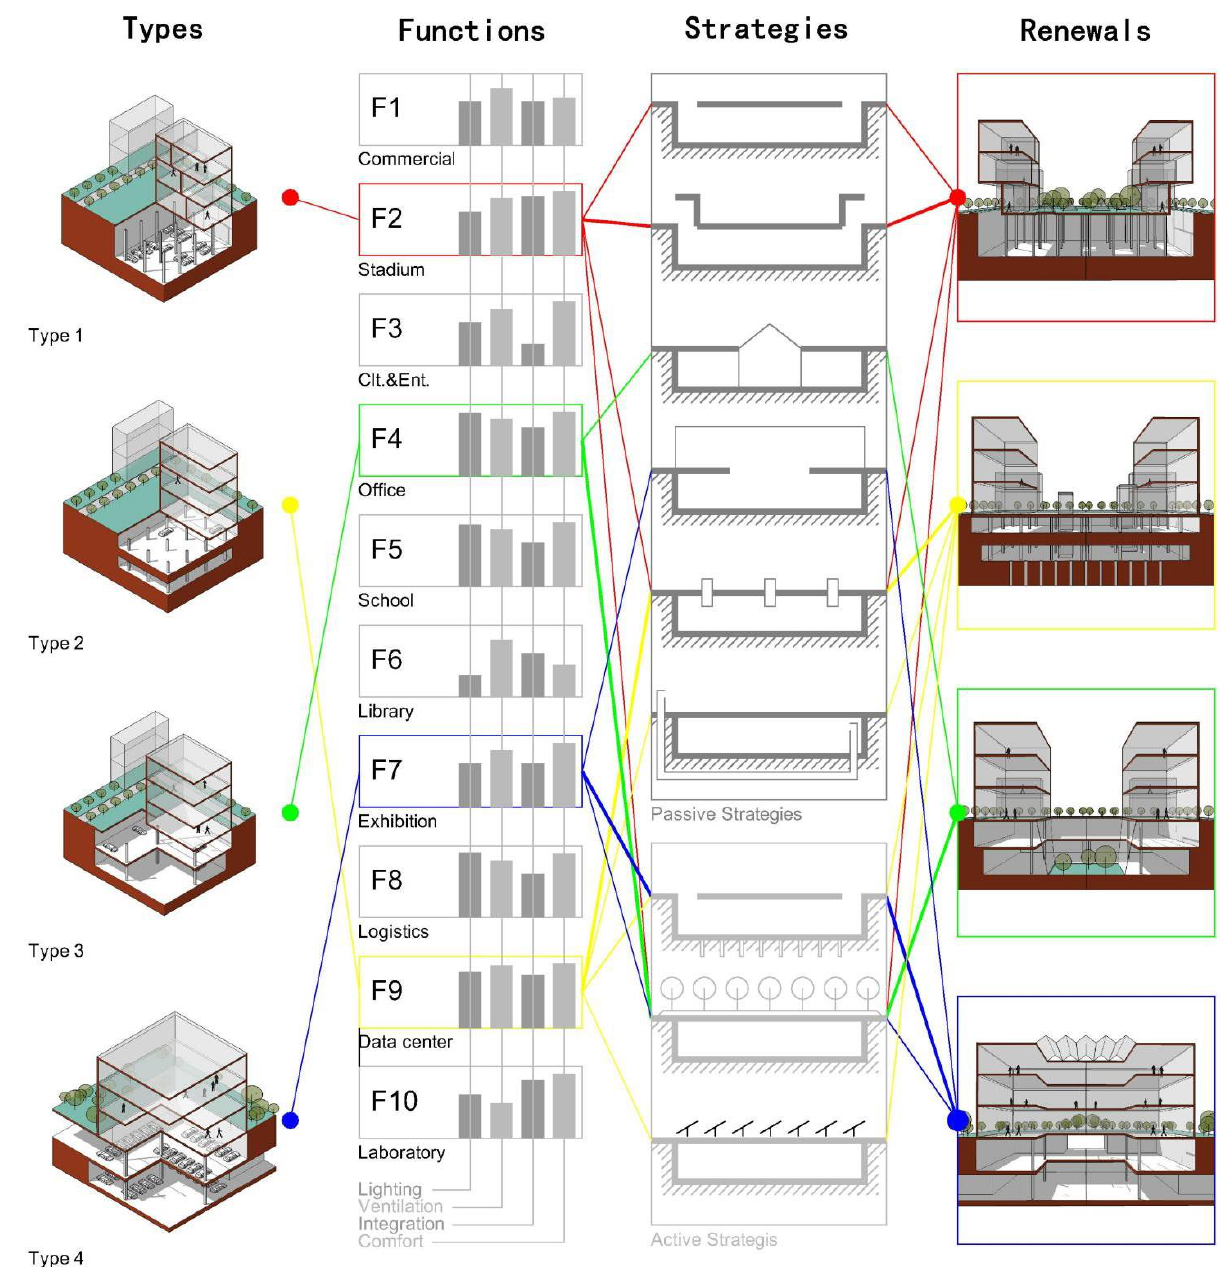
Figure 10. Comparisons of renewal strategies for UPS types.